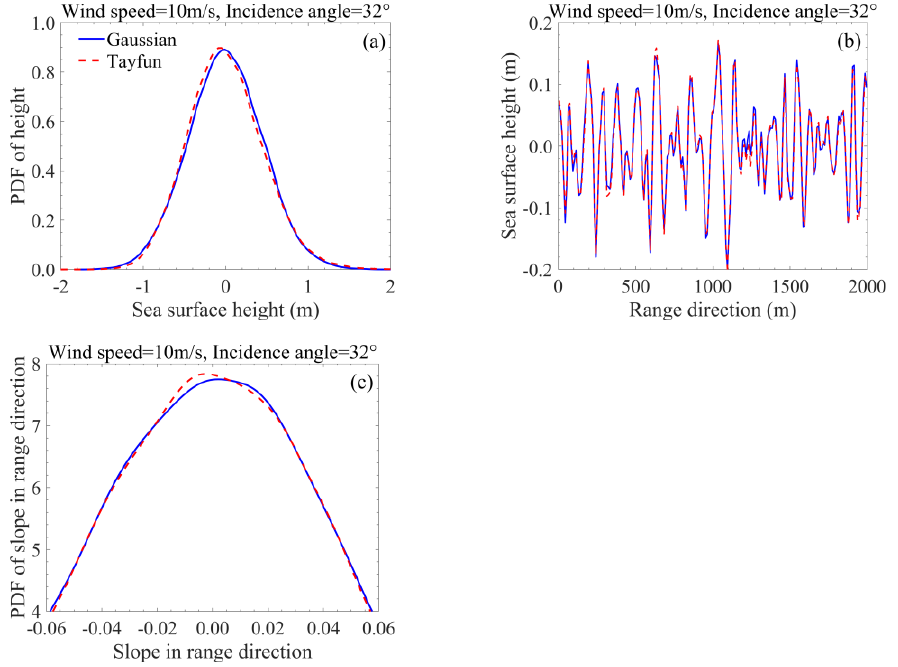
Figure 7. Comparison of a Gaussian sea surface and Tayfun sea surface at 10 m/s wind speed and 32° incidence angle in the upwind direction. ( a ) Pdfs for surface elevations; ( b ) profiles of surface elevations; ( c ) pdfs for slopes along range direction. Blue solid curve, Gaussian sea surface; red dashed curve, non-Gaussian sea surface constructed by Tayfun model.